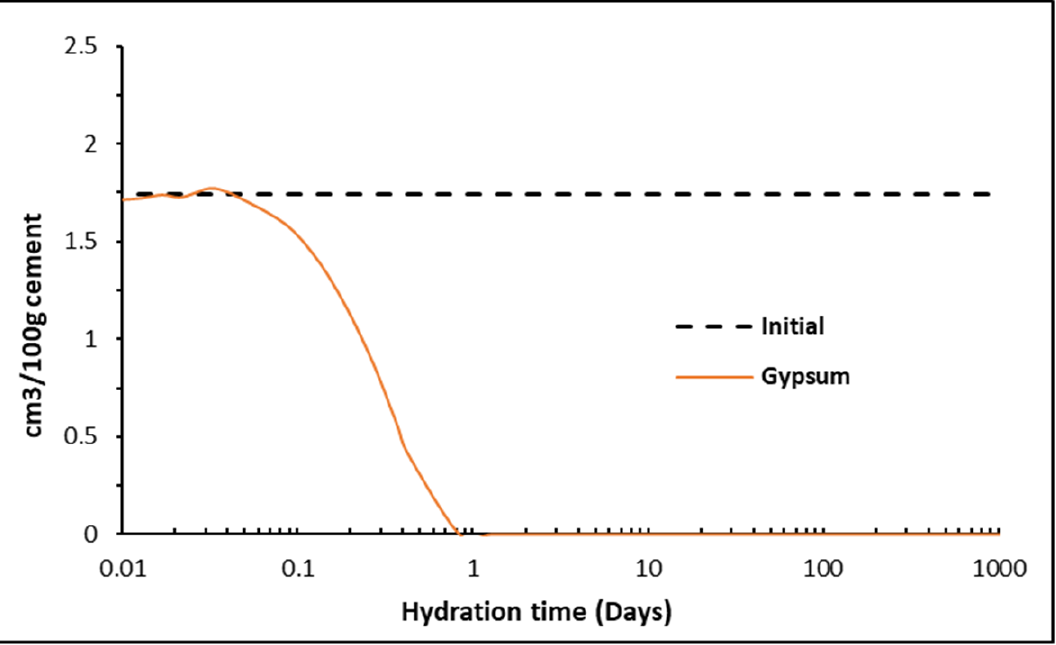
Figure 12. Dissolution of gypsum over time showing some precipitation from Na 2 SO 4 , K 2 SO 4 and SO 3.